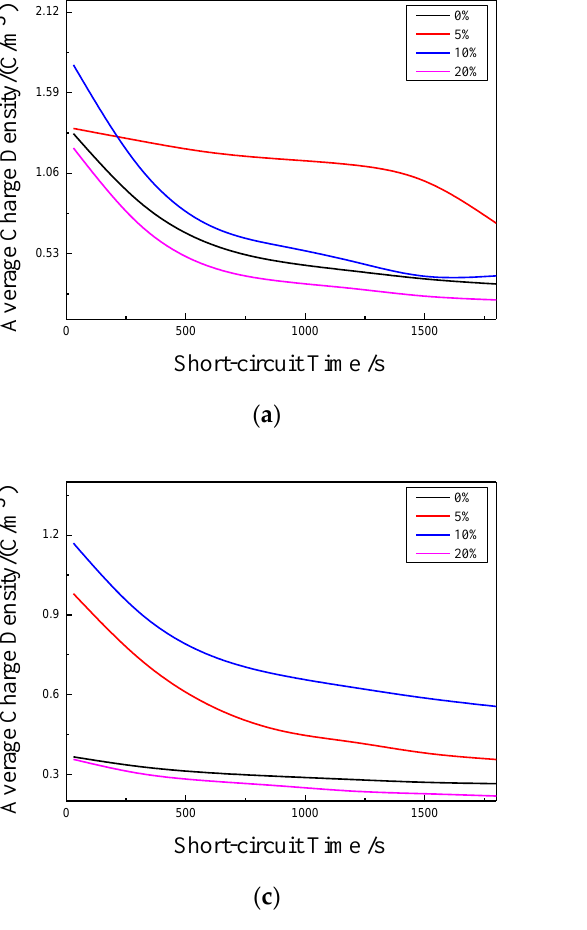
Figure 12. Average charge density curve of each sample. ( a ) Sample 1; ( b ) Sample 2; ( c ) Sample 3; ( d ) Sample 4.